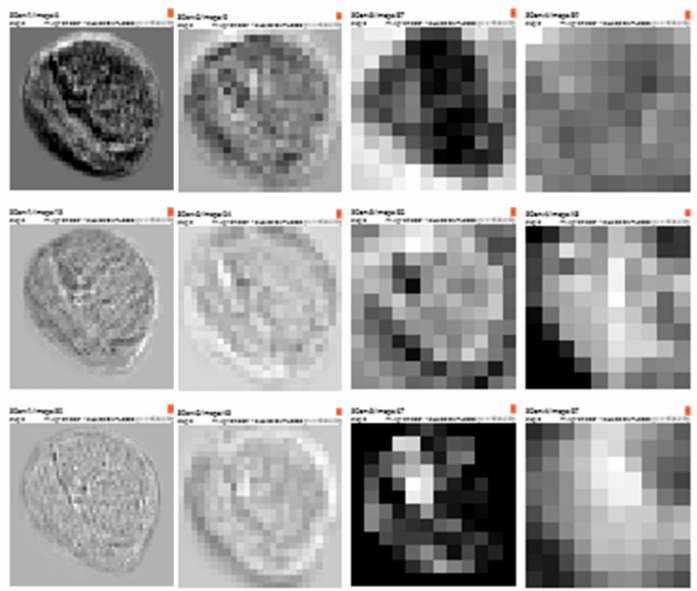
Figure 12. Convolution visualization results of the new network-dr-pv model (the columns of images from left to right represent the results obtained for Convolutional Layers 1–4).